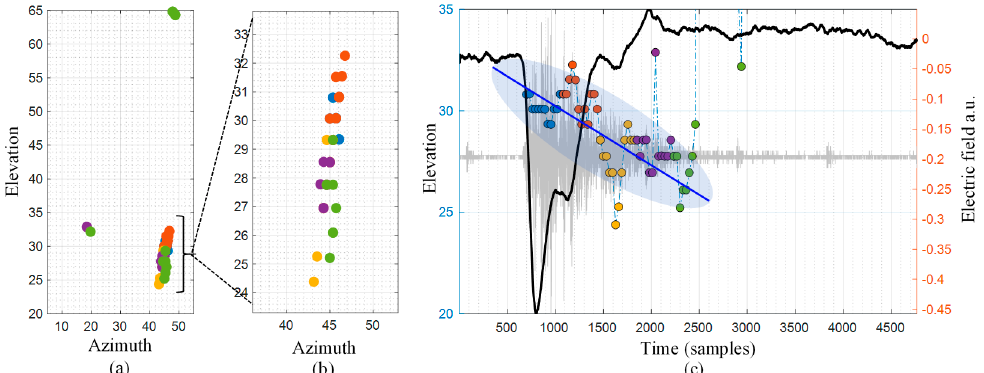
Figure 10. Interferometer data for NBE. ( a ) Lightning map plotted in elevation vs. azimuth. ( b ) Expanded view of the lightning map of a. ( c ) Showing the breakdown, each colored circle-marker denotes the elevation angles (altitude) vs. time.